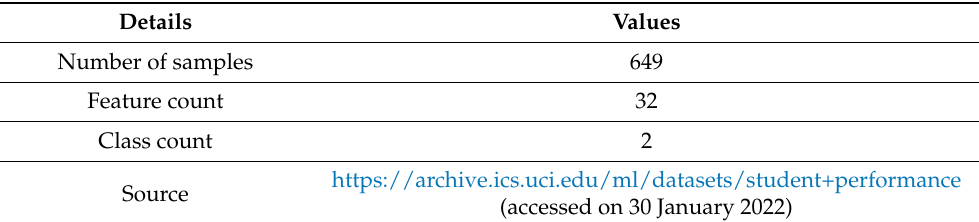
Table 1. Dataset details.